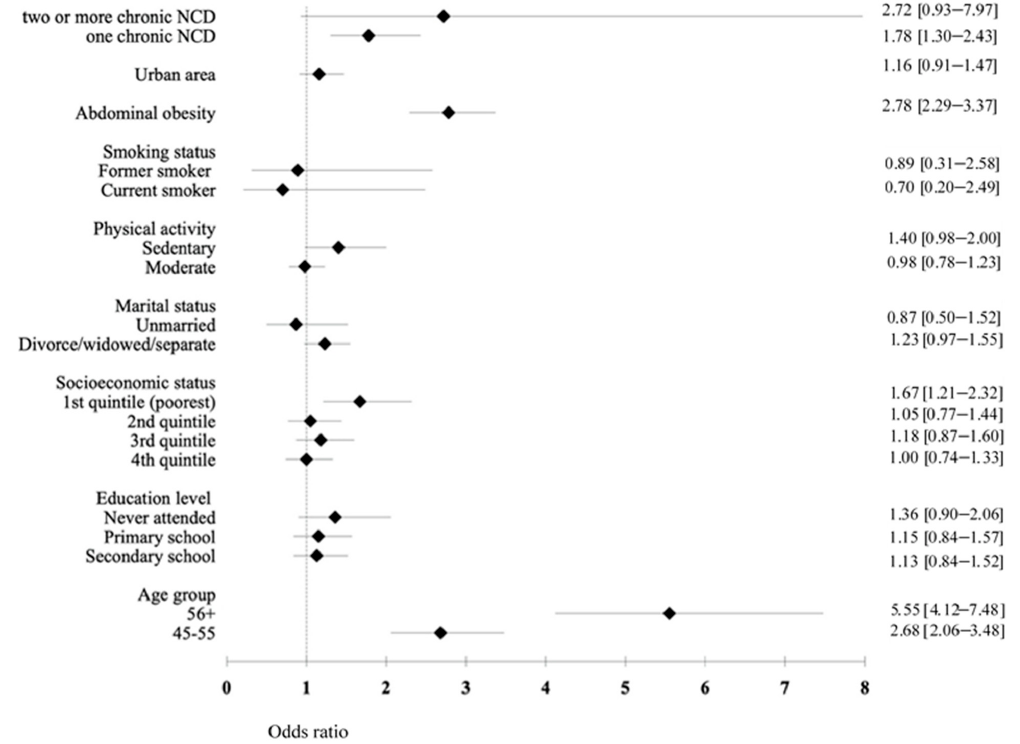
Figure 2. The odds of the association between sociodemographic variables, socioeconomic status, health behavior, and hypertension in women. We calculated the predicted probability of hypertension by abdominal obesity among men and women (Figure 3). The probability of having hypertension was predicted to increase as age increases, particularly for men with abdominal obesity.